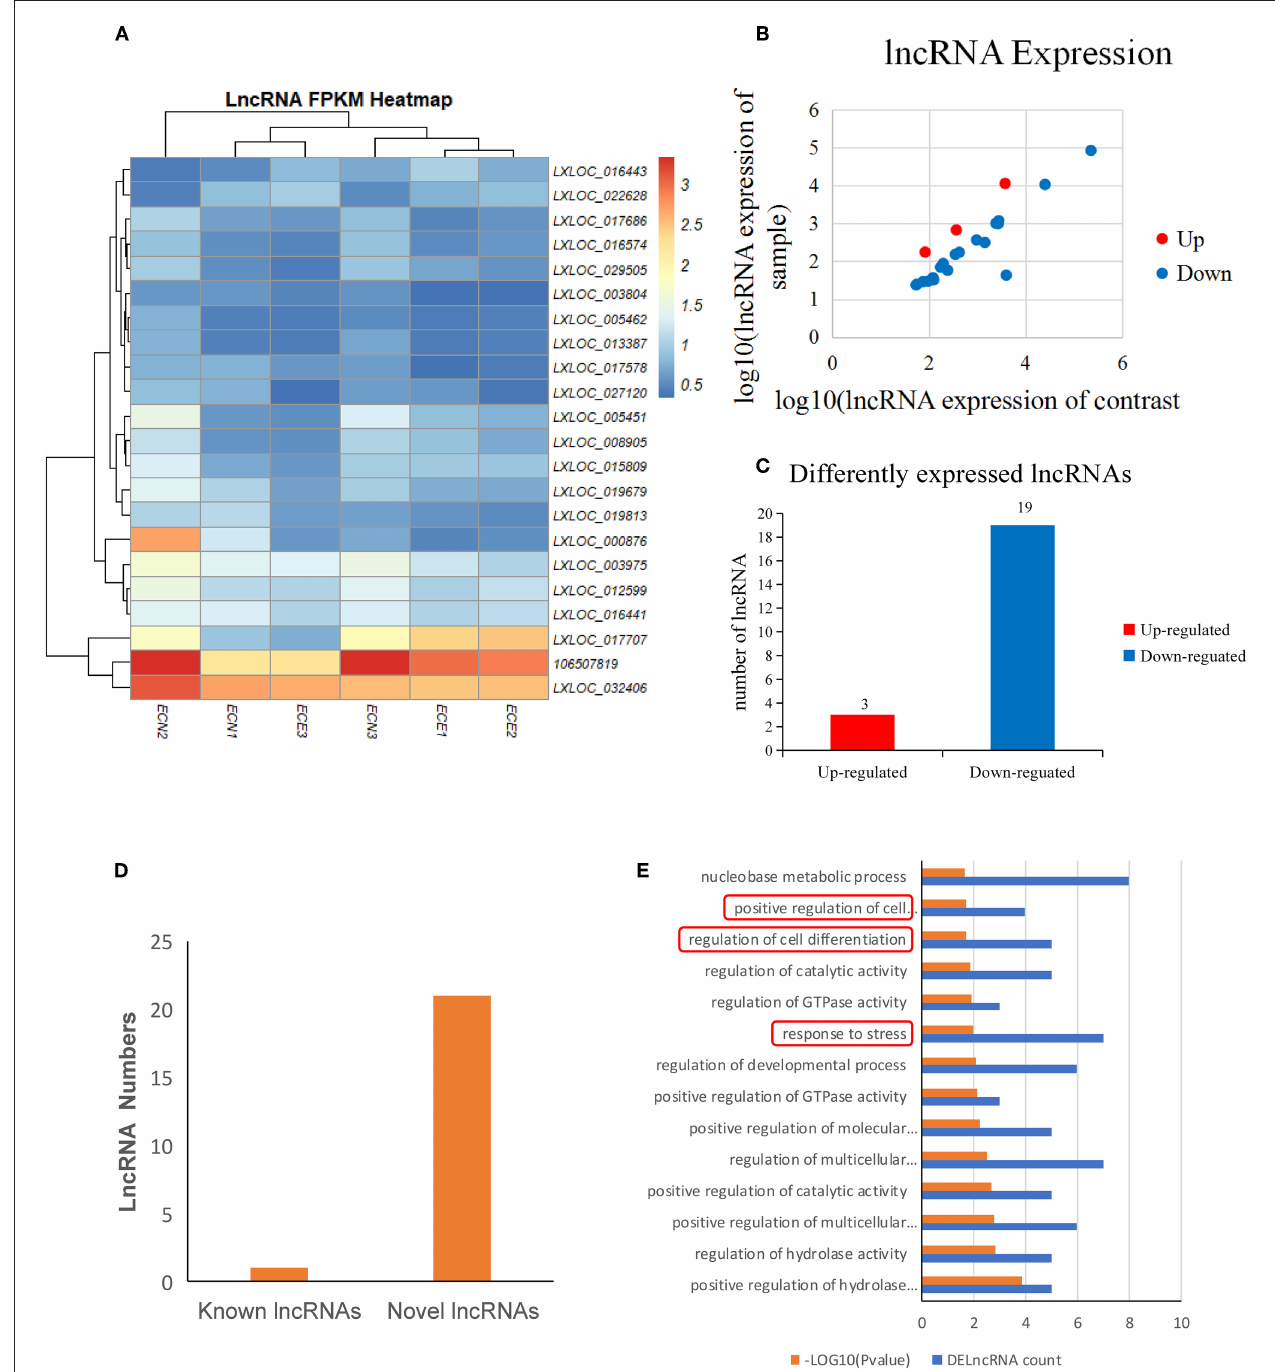
FIGURE 4 | Screening and enrichment analysis of differently expressed lncRNAs (DElncRNAs) in PRRSV-infected PECs compared with non-infected PECs. (A) Hierarchical clustering analysis (heatmap) for DElncRNAs using Pearson’s correlation. (B) DElncRNA expression level analysis by scatter plot. The red spots in this figure indicate up-regulated lncRNAs, the blue spots indicate down-regulated lncRNAs. (C) Detailed analysis on the up-/down-regulated DEGs. Three up-regulated DelncRNAs and 19 down-regulated DelncRNAs were shown. (D) Known and novel lncRNAs identified in this study. One known DElncRNAs and 23 novel DElncRNAs were shown. (E) The first 20 GO terms analysis ( P < 0.005) of DElncRNAs in biological processes. The red textbox in the figure indicate the main processes that are related into cells immunology and differentiation. A–log 10 ( P- value) > 2 was considered as significantly different.